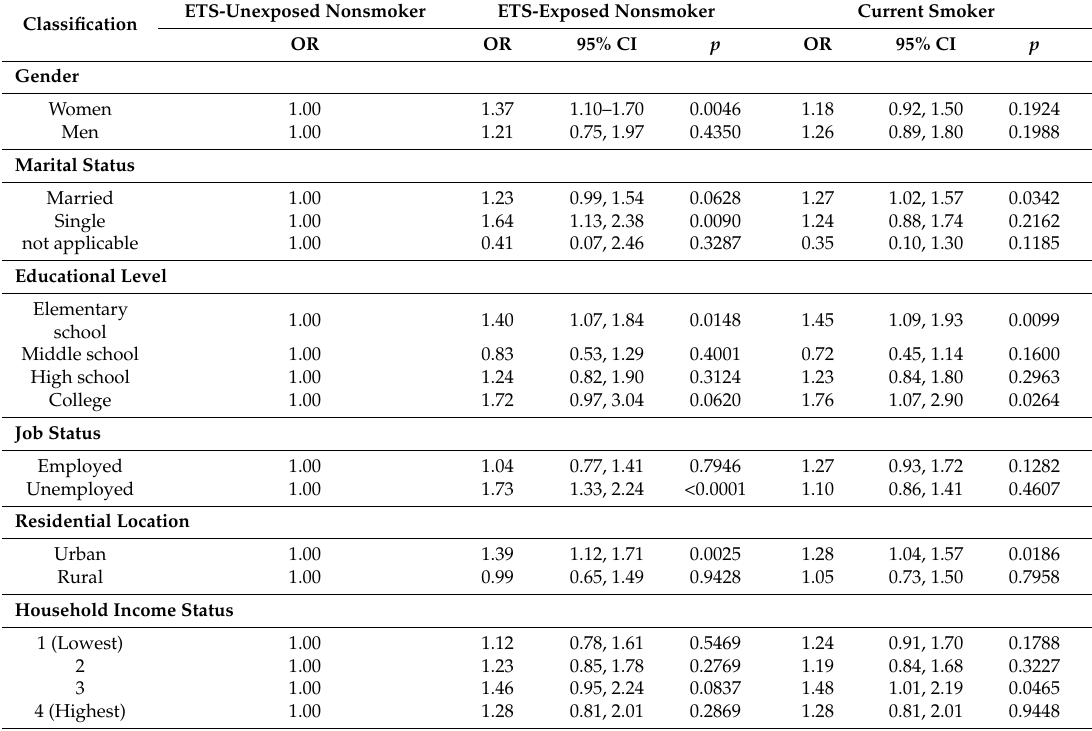
Table 3. Odds ratios for diabetes for each subgroup by independent risk